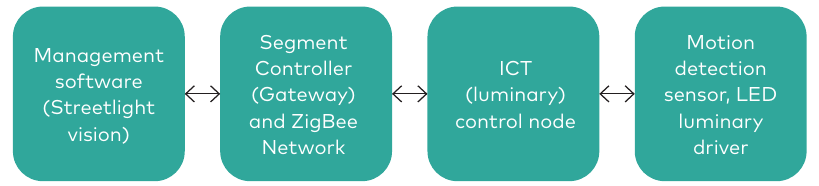
Figure 7. Smart street lighting system layout created in LITES project and used in Riga